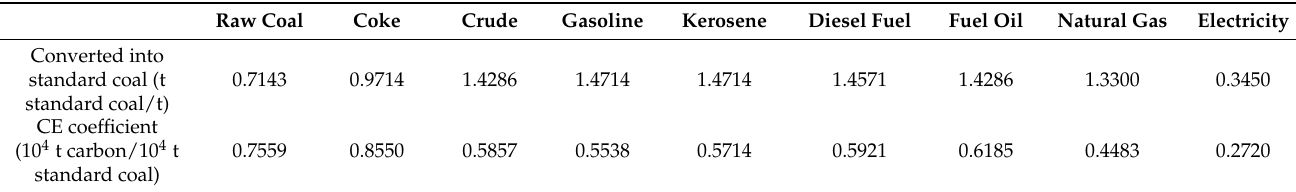
Table 1. CE coefficients of various energy